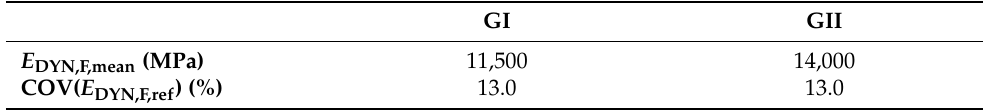
Table 6. Parameters for the dynamic modulus of elasticity. GI GII E DYN,F,mean (MPa) 11,500 14,000 COV( E DYN,F,ref ) (%) 13.0